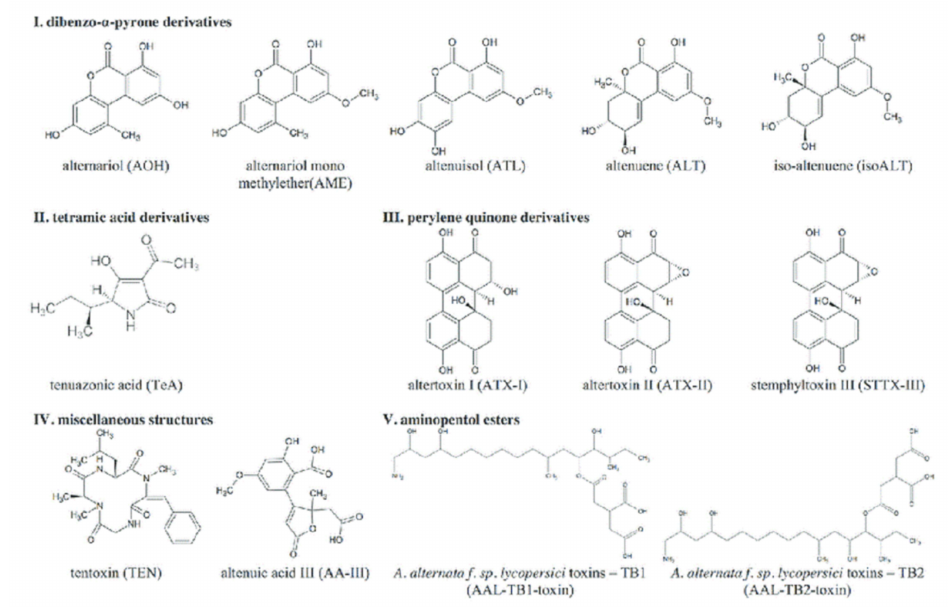
Figure 3. The chemical structures of common Alternaria toxins (Reprinted/Adapted from sources